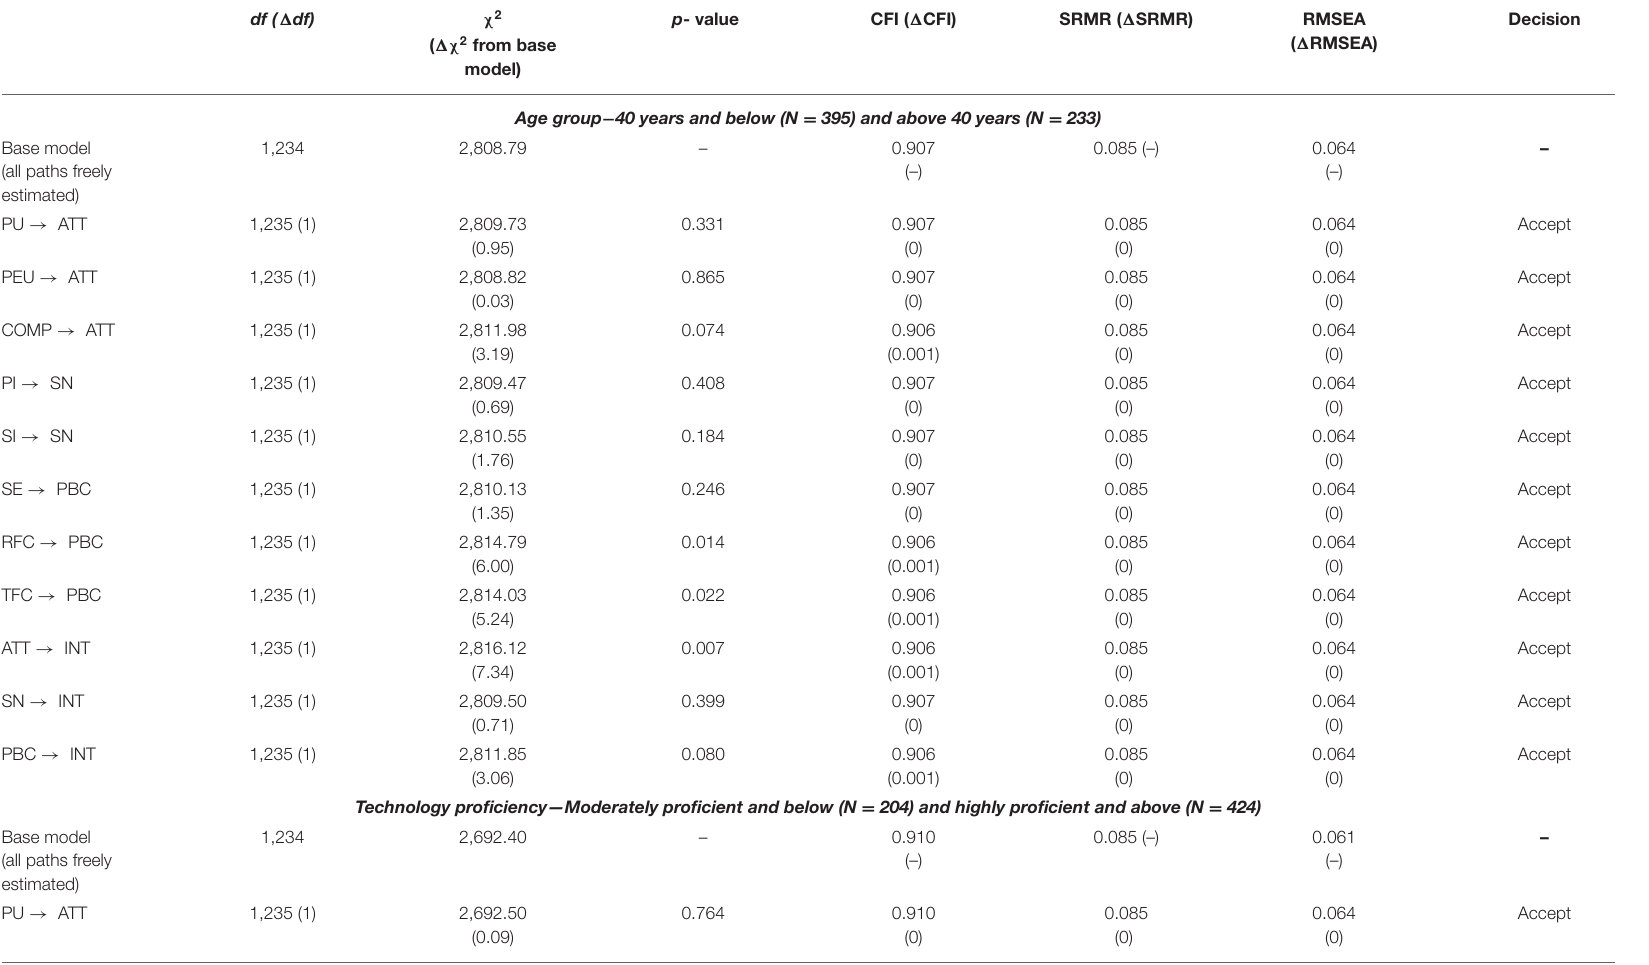
TABLE 5 | Regression path